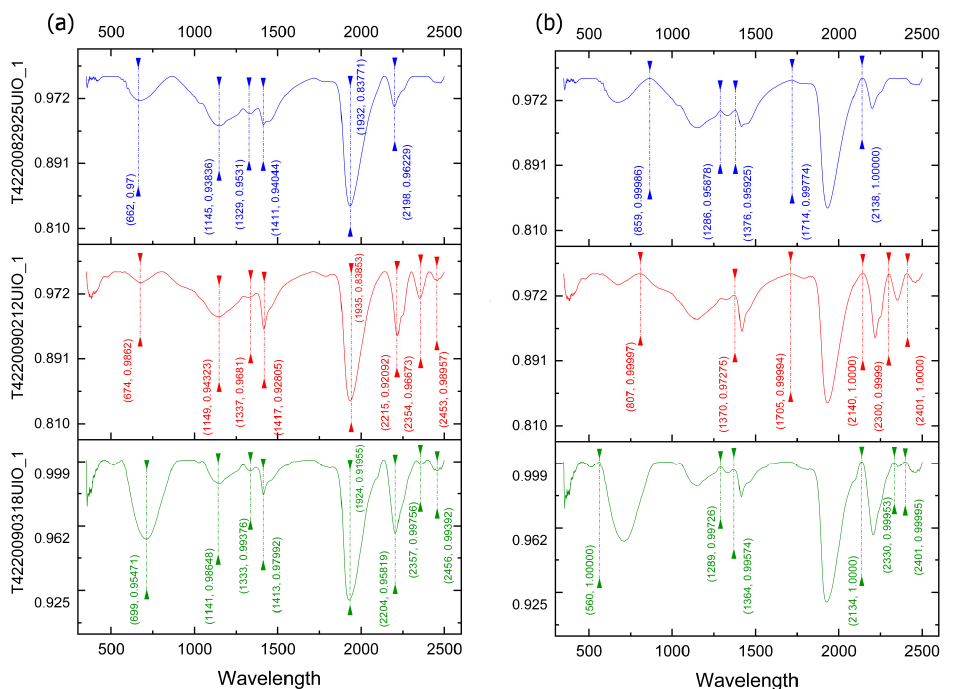
Figure 10. Absorption and reflectance peaks from spectra collected from samples of Tysfjord plagi- oclases. ( a ) Main absorption peaks (minimum). ( b ) Main reflectance peaks.